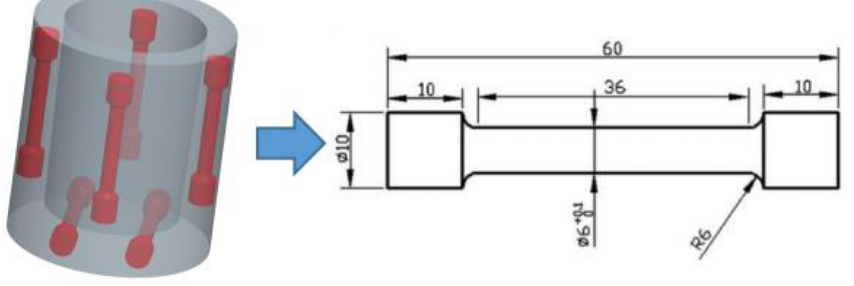
Figure 3. Sampled location and drawing of tensile specimens.